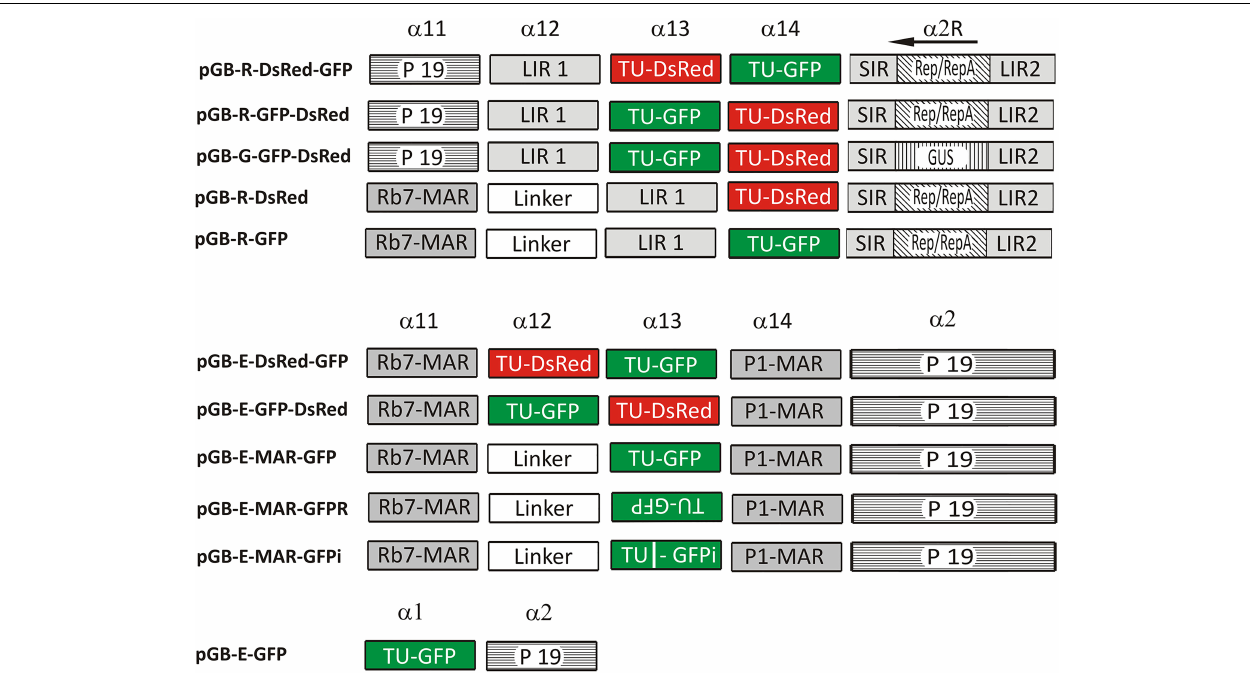
FIGURE 3 | Schematic representation of constructed assemblies. pGB, GoldenBraid plasmids; R, replicating constructs; G, contains GUS gene instead of Rep; E, non-replicating vectors derived from pEAQ; GFP/DsRed, fluorescent reporter genes under 35S promoter, Nos terminator with CPMV derived 5 (cid:48) /3 (cid:48) UTRs; GFPR, identical GFP fluorescent reporter cassette in reverse orientation; GFPi, GFP reporter cassette in which short intron was inserted between CPMV 5 (cid:48) NTR and GFP start codon; MAR Rb7/P1, matrix attachment regions; Linker, stuffer fragment is a 35 bp long linker; P 19, silencing suppressor derived from Tomato bushy stunt virus. LIR 1, 2, long intergenic region derived from BeYDV; SIR, short intergenic region derived from BeYDV.